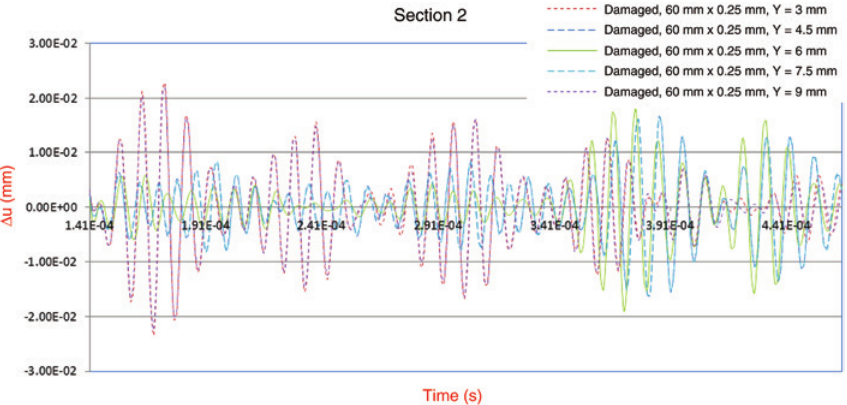
Figure 25: Time domain response at Section 2 with varying damage